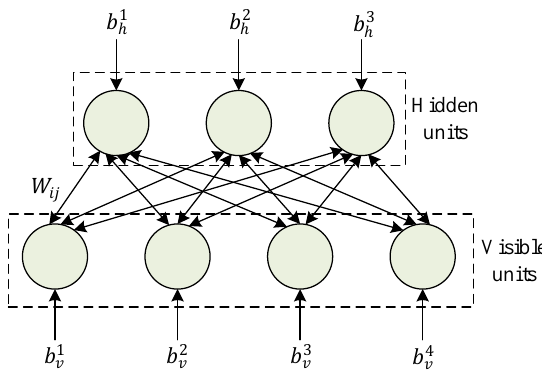
Figure 7. The architecture of the restricted Boltzmann machine.